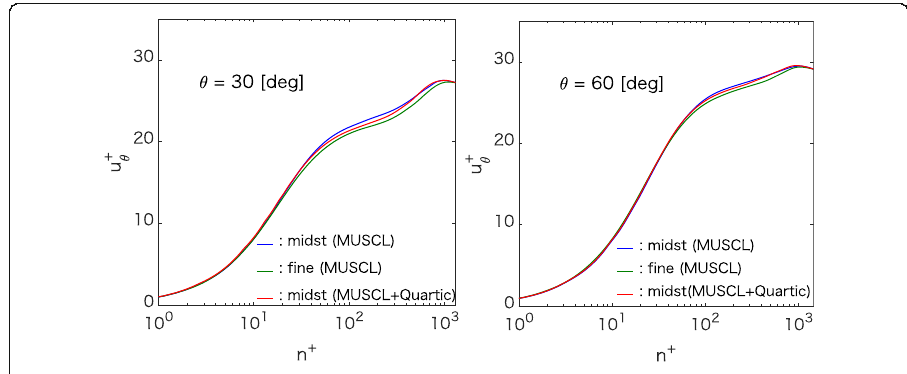
MUSCL+Quartic does (S2)